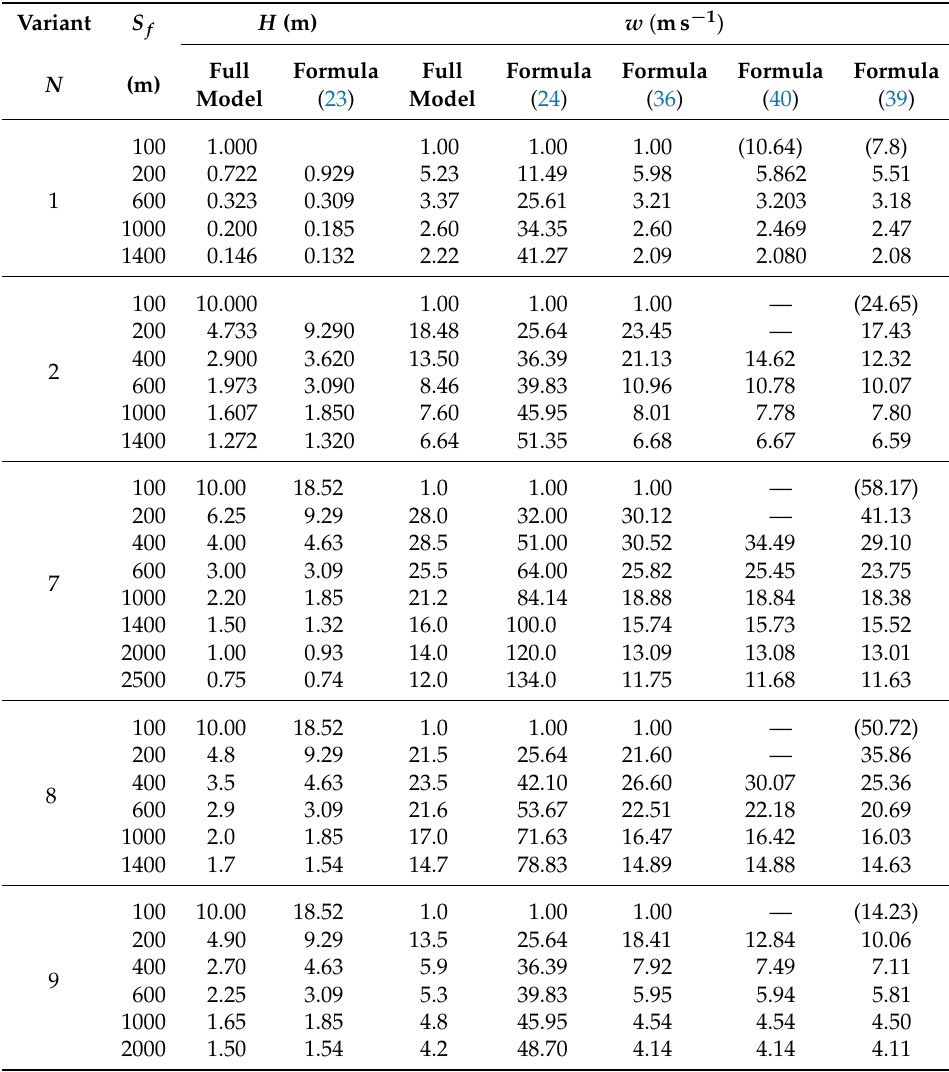
Table 2. The results of calculations with the full model (Section 2), the simplified model of Section 3 (formulas (23) and (24)), and the improved simplified model described in Section 5 (formulas (36), (39) and (40)) are presented in terms of the flow depth H and the front velocity w as functions of the front position S f . For the simplified models, the value of the shape factor was always chosen as κ = 0.36 ([1], Note